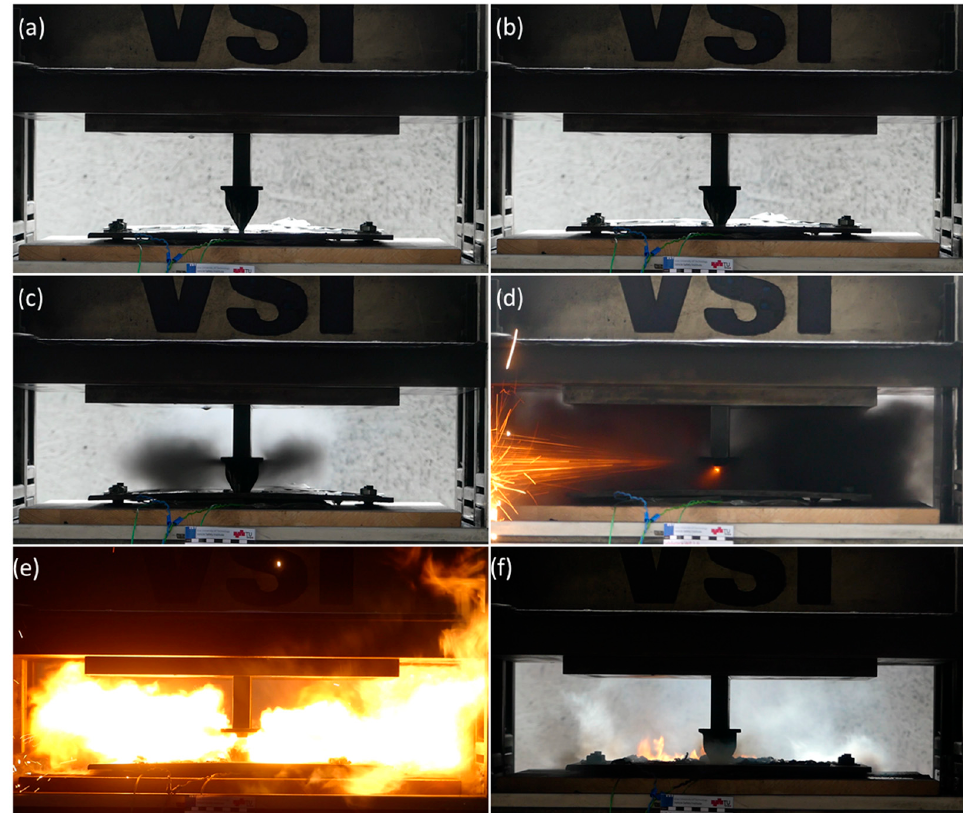
Figure 6. Screenshots highlighting video-documented phases observed during tests. ( a ) Nail position before the penetration ( t = 0 s); ( b ) nail penetrates through half of the stack ( t = 5 s); ( c ) the increase in the internal cell pressure causes the top steel plate to bend and the initially produced gas to vent through the steel plate hole ( t = 11 s); ( d ) sparks and embers occur during the violent gas venting stage; ( e ) vented gas ignites (potentially triggered by sparks) and, at this stage, the fire is actively sustained by the gas venting ( t = 16 s); and ( f ) cell cools down slowly until reactants are completely consumed, while the internal electric current activity may still be ongoing ( t > 40 s).